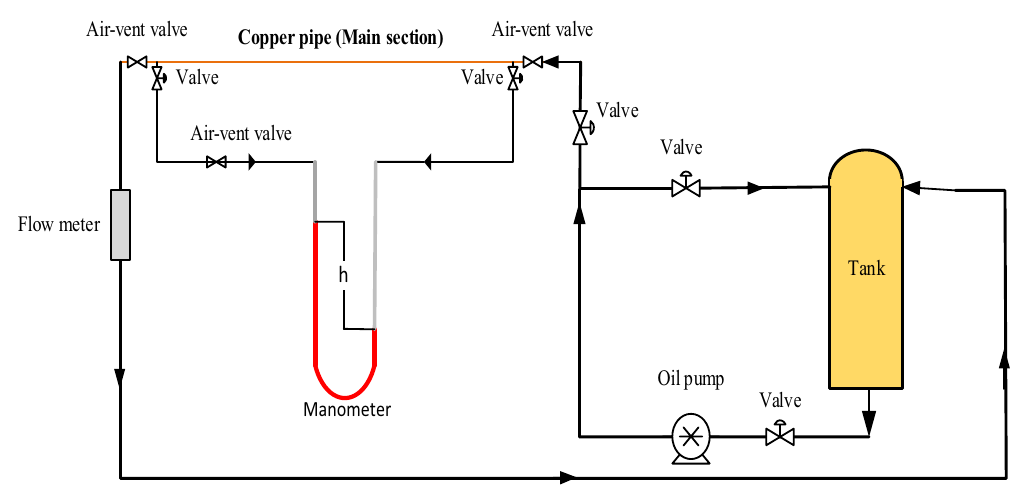
Figure 1. Schematic of the experimental